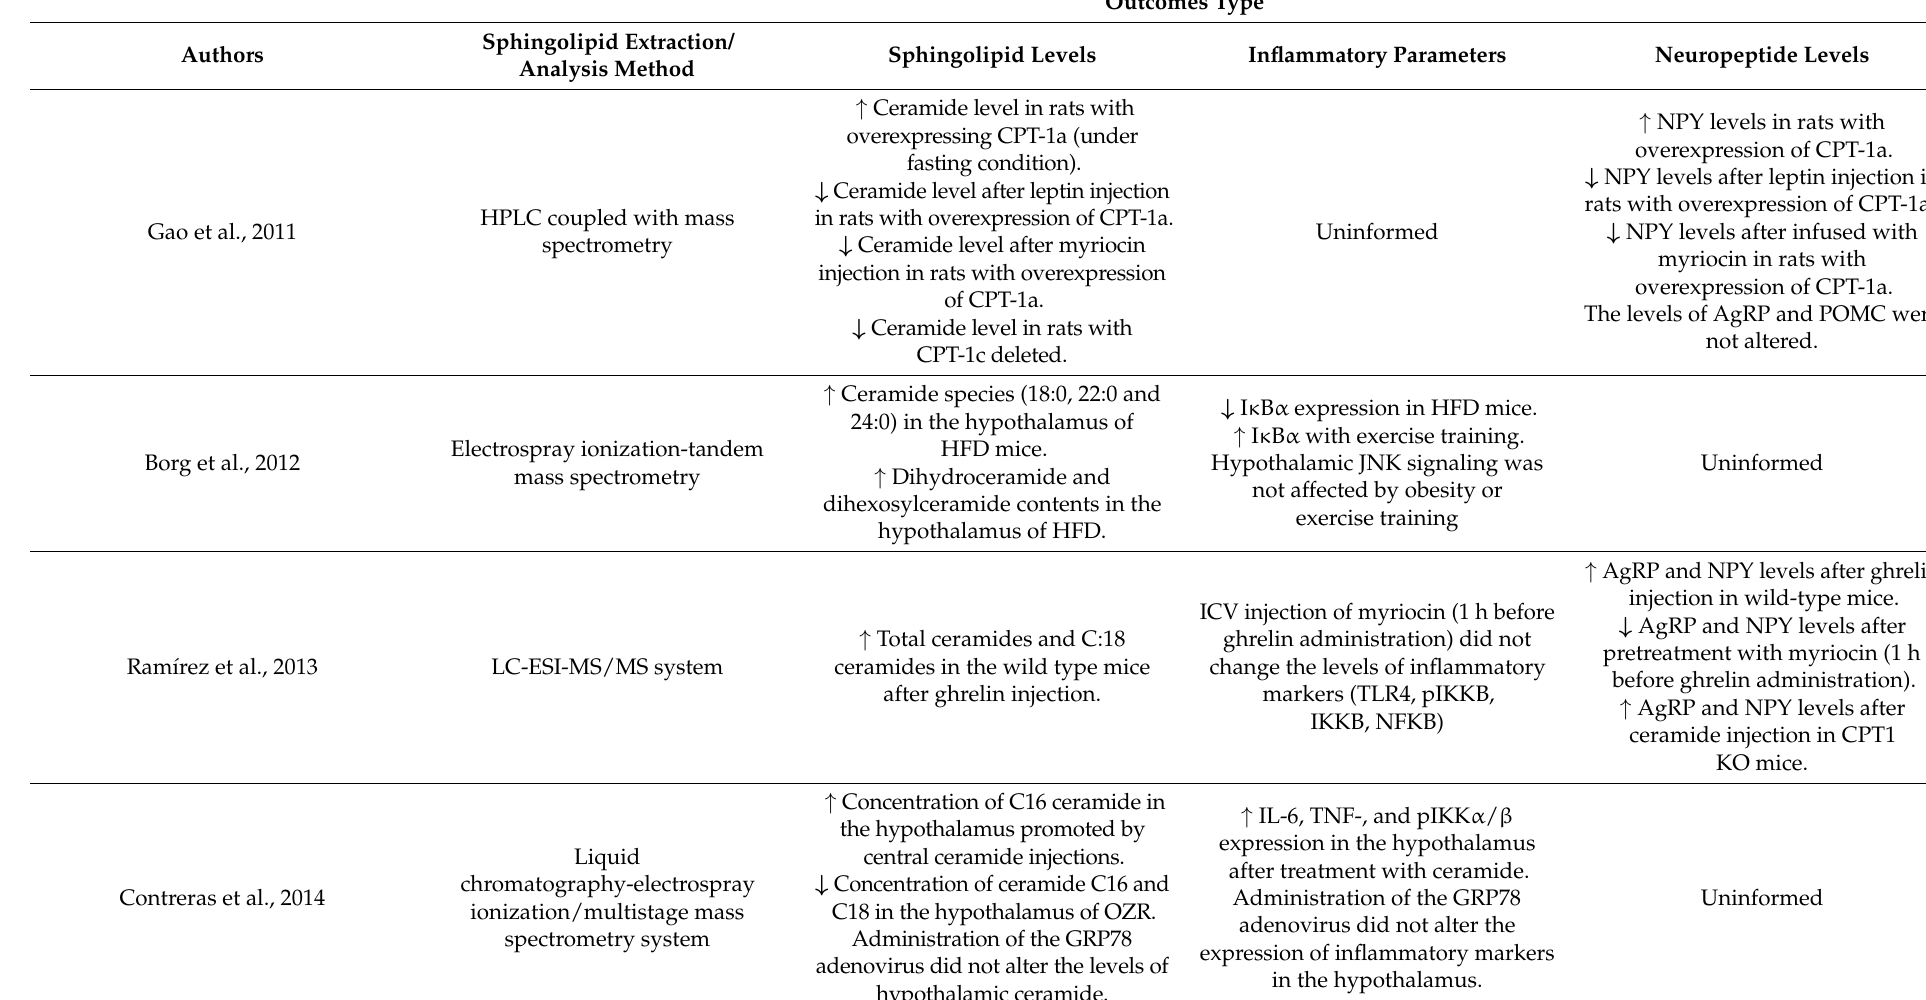
Table 4. Analysis of outcomes for in vivo